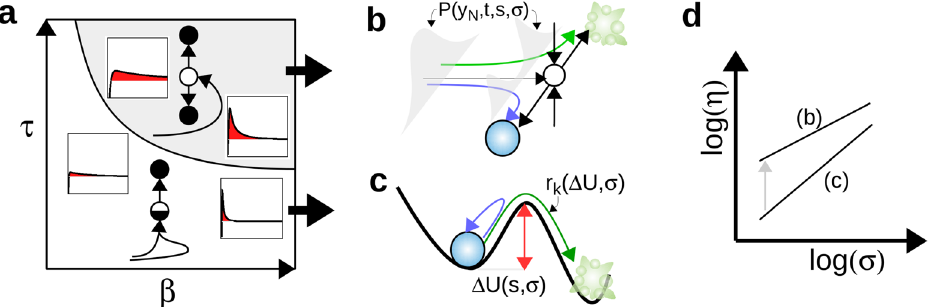
Figure 5. From deterministic to stochastic properties of two distinct cell-fate decision scenarios. ( a ) Deterministic decision mechanims in the space of adaptation parameters. ( b – c ) Corresponding stochastic decision mechanisms. ( d ) Qualitative change of fractionality